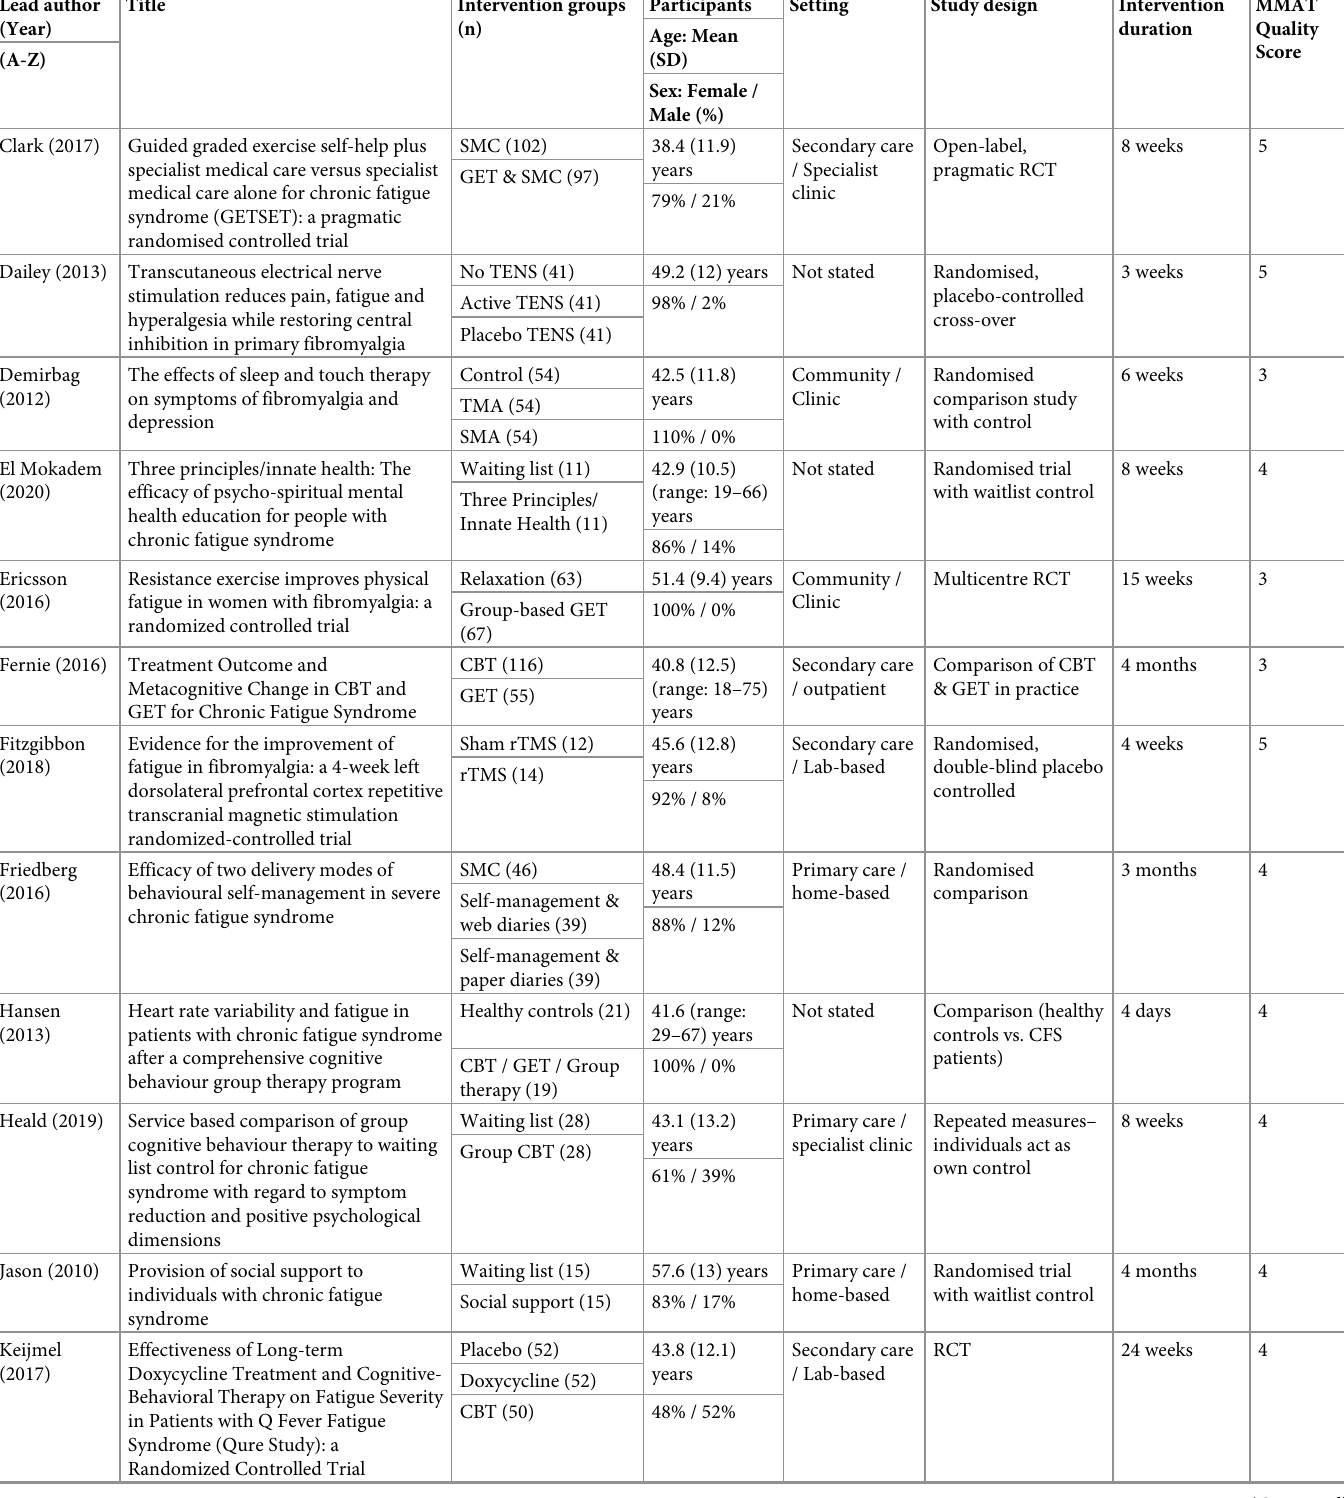
Table 1. Overview of studies selected for